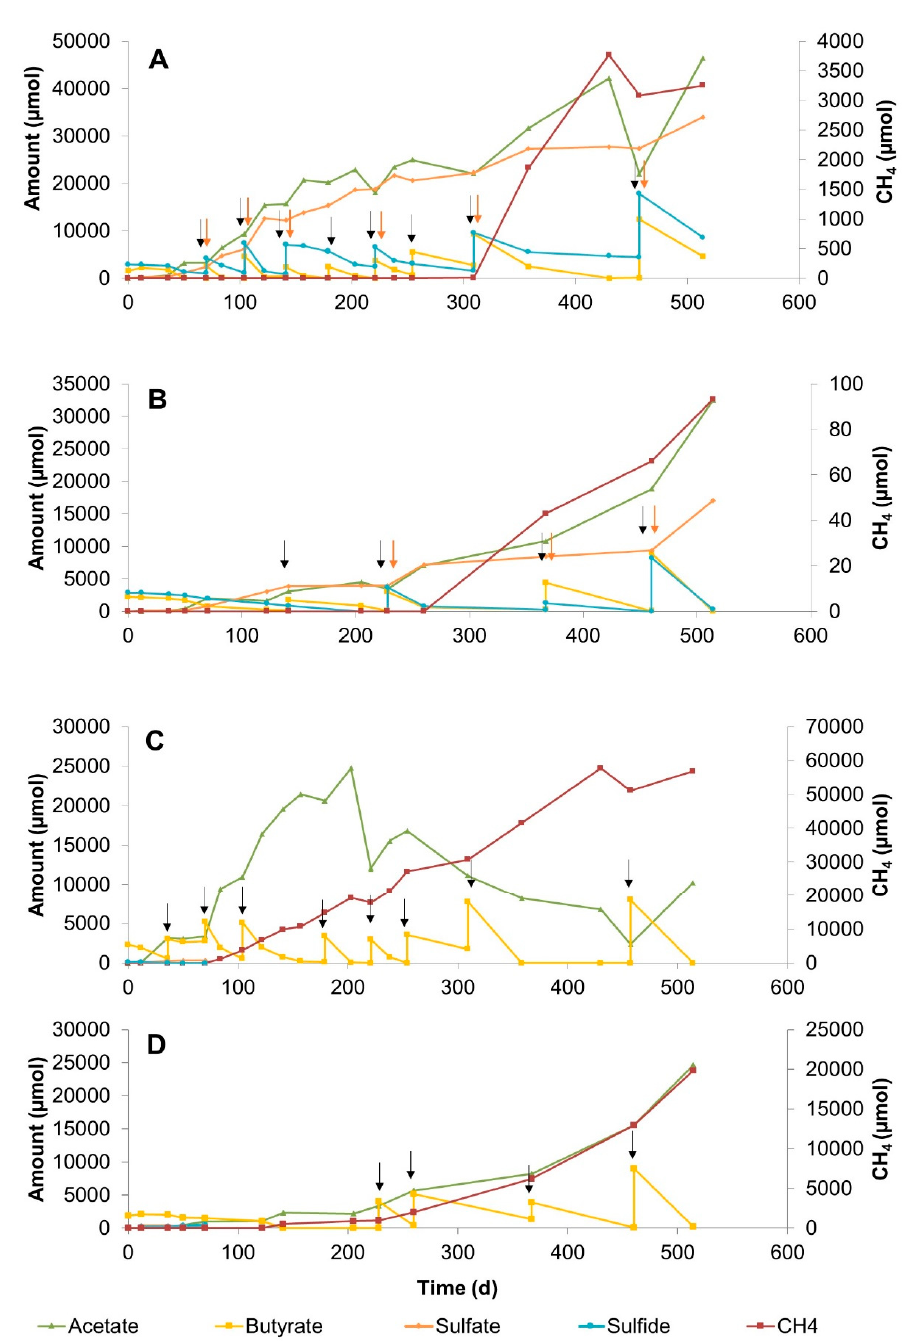
Figure 1. Changes in butyrate, sulfate, acetate, sulfide, and methane concentrations during 514 days of incubation in sediment slurry enrichments constituted of sulfate zone sediment. ( A ) Slurry SZB4, with 20 mM sulfate addition at 25 °C, ( B ) Slurry SZB7, with 20 mM sulfate addition at 10 °C, ( C ) Slurry SZB1, without sulfate addition at 25 °C, ( D ) Slurry SZB5, without sulfate addition at 10 °C. Arrows denote the time points for the additions of sulfate (red) and butyrate (black).